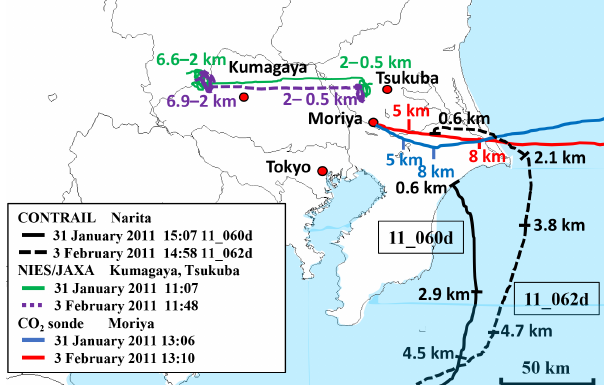
Figure 7. The CO 2 vertical profiles obtained by the CO 2 sonde (cir- cles connected with blue lines), NIES/JAXA chartered aircraft data (dots connected with green lines), and the CONTRAIL data (dia- monds connected with black lines) on 31 January 2011.